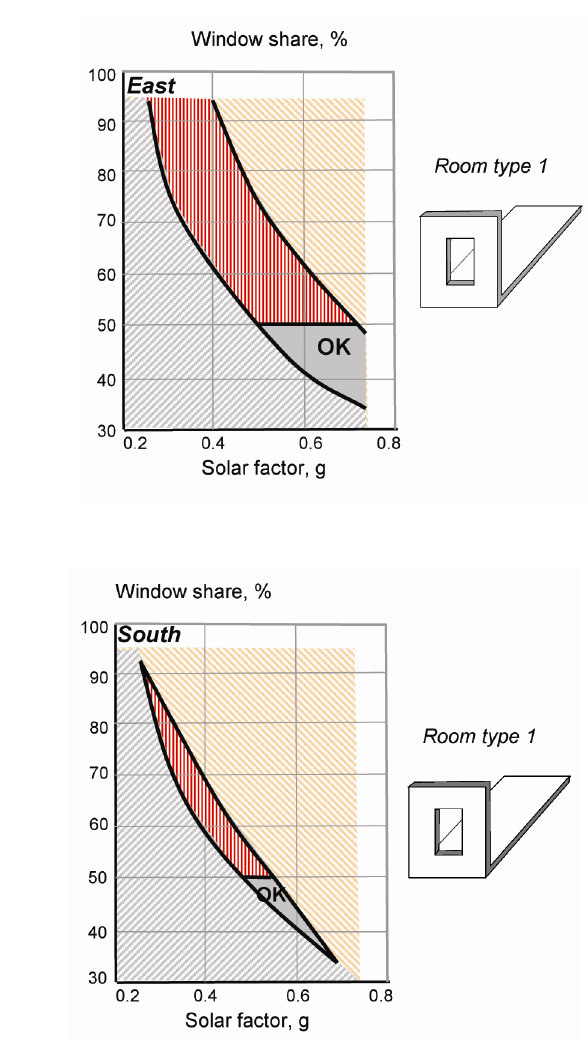
Fig. 17. Possible combinations of window glass share and solar factor for room type 1 that fulfil the requirements for a cooling power 2 2 demand below 100 W/m , a heating power demand below 30 W/m , a daylight factor above 2, and a difference between the highest 2 and lowest daylight factors of less than 20. Glass U-value = 1.2 W/(m